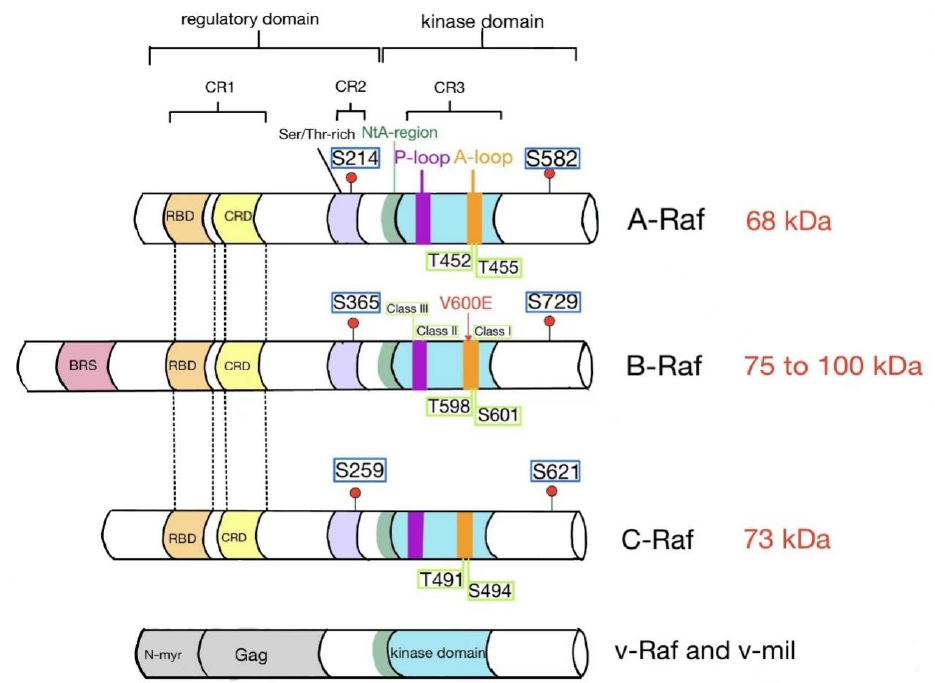
Figure 1. Structure of Raf family kinases. All Raf isoforms comprise three conserved regions: conserved region 1 (CR1) contains a Ras-binding domain (RBD) and a Cys-rich domain (CRD); conserved region 2 (CR2) is characterized by a Ser/Thr-rich sequence where 14-3-3 binds and inhibits Raf; conserved region 3 (CR3) is the kinase domain where the B-Raf V600E mutation is found in cancer. At the C-terminus, the second site promotes dimerization via binding to 14-3-3. BRS is a B-Raf-specific site. The viral oncoproteins v-Raf and v-mil have amino-terminal truncations and are fused with the N-myristoylated (N-myr) viral Gag protein. Four conserved phosphorylation sites of each Raf isoform are indicated in rectangles, including 14-3-3 binding sites and phoshorylattion sites in the activation loop. NtA: N-terminal acidic